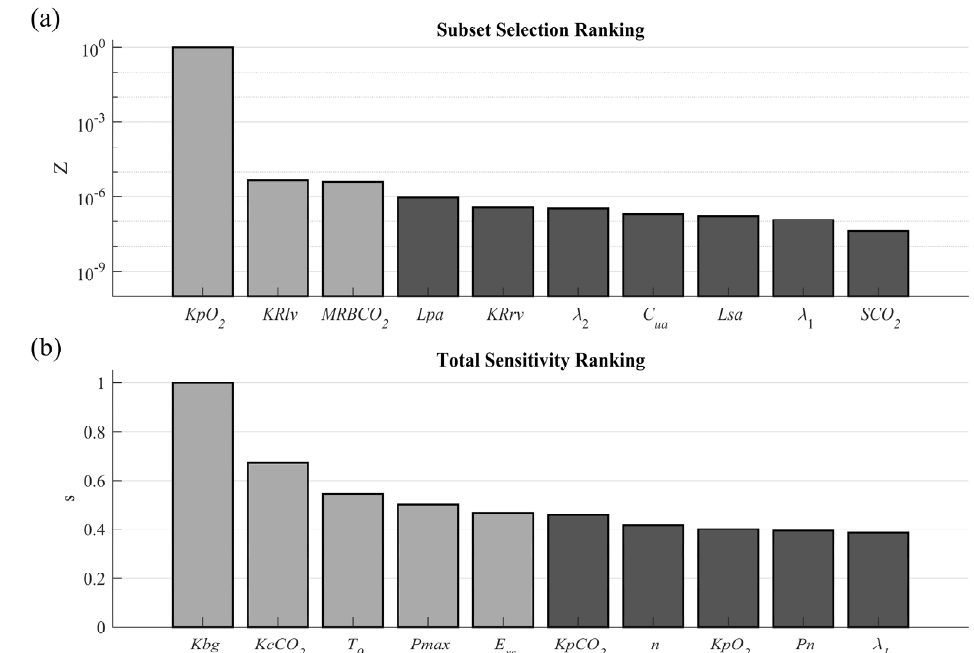
Figure 2. Top ten positions in the rankings of classification techniques: ( a ) correspond to the results for subset selection and ( b ) to the results for sensitivity analysis techniques. The light gray bars correspond to the selected base setting parameters, and the dark gray bars correspond to the parameters that will remain fixed at the nominal values.